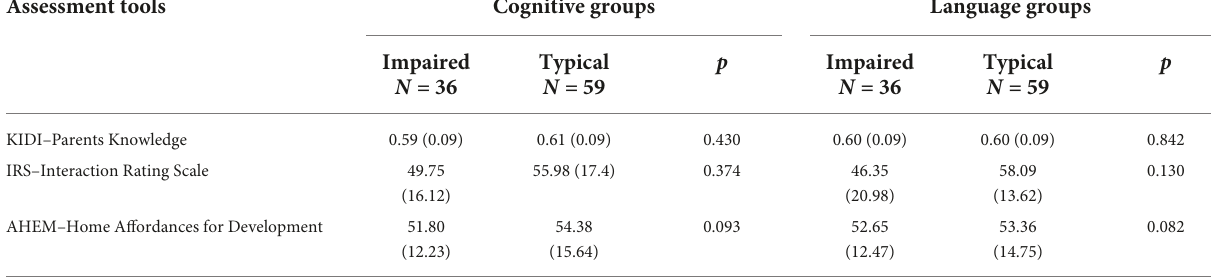
TABLE 1 Maternal practice and knowledge, and home opportunities.